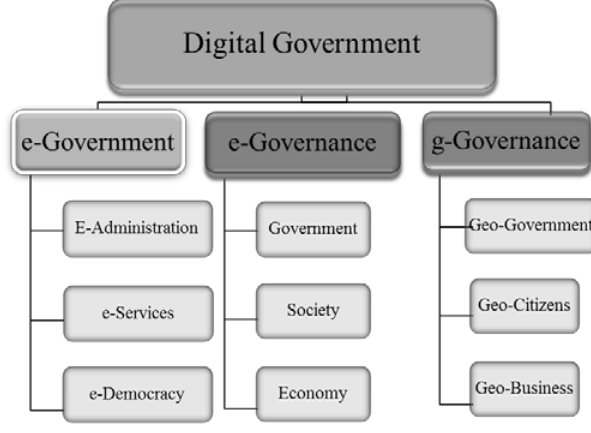
Figure 2: A new typology of digital government. Modified after (Schellong,